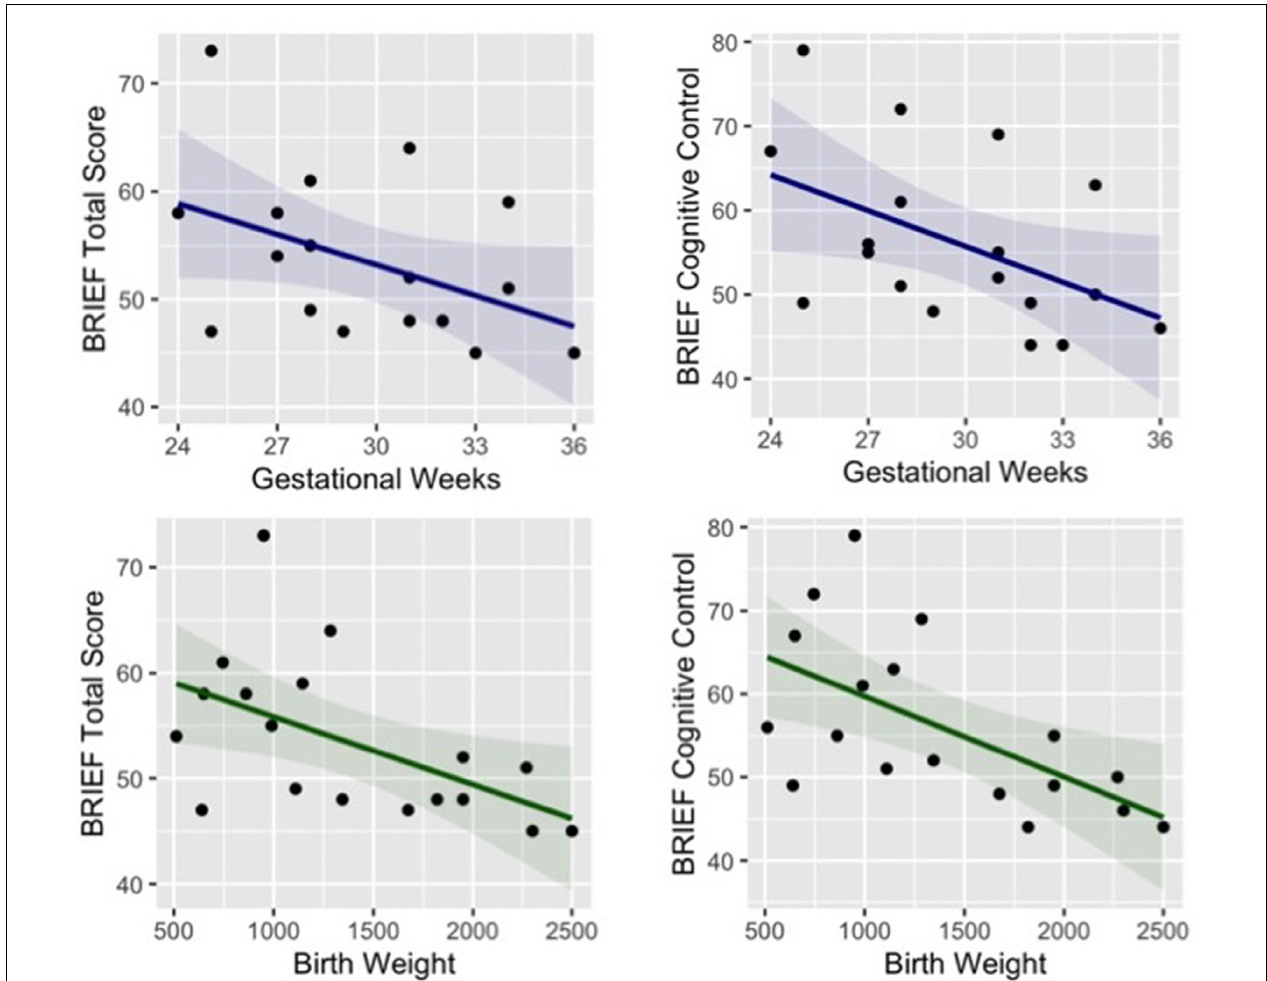
FIGURE 3 | Correlation between preterm children’s gestational age (blue) and birth weight (green) and their parent-reported difficulties in executive functions (total score and subscale of cognitive